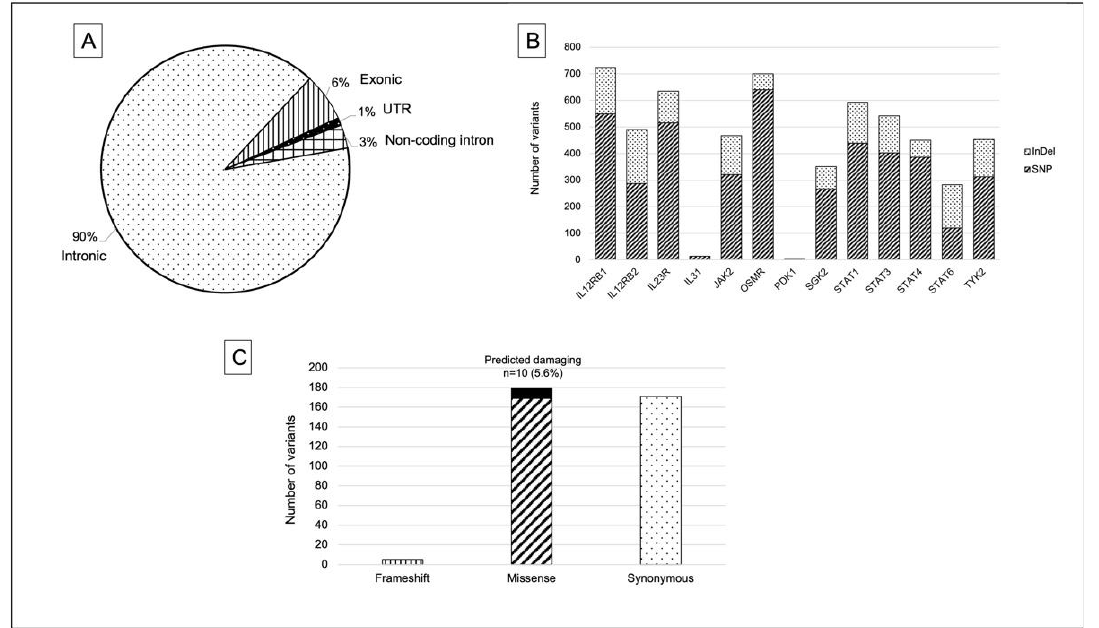
Figure 1. ( A ) Pie chart displaying the overall distribution of the variants identified in PI3K-related genes. ( B ) A bar column showing the total number of variants discovered in each PI3K-related gene and fractionated into Indel and SNPs. ( C ) Bar charts displaying the different somatic alterations found in the exonic region across all samples.